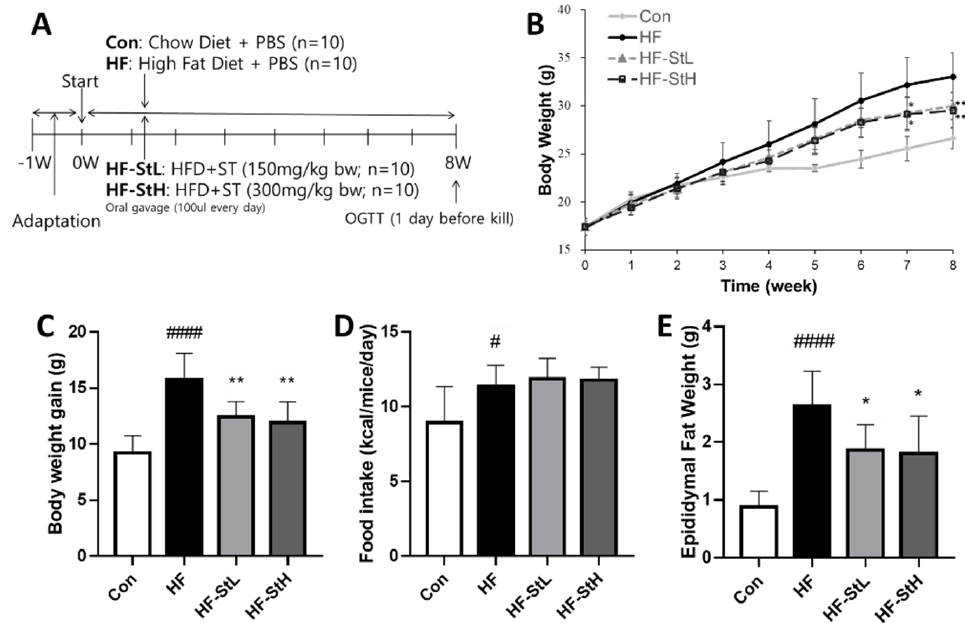
Figure 4. Effects of S. thunbergii (ST) extract on body weight and organ weight in high-fat-fed C57BL/6 mice. ( A ) Experimental timeline. ( B ) Trend of body weight change for 10 weeks. ( C ) Body weight gain. ( D ) Average food intake for 10 weeks. ( E ) Epididymal fat weight. Con: chow diet, HF: high-fat diet, HF-StL: high-fat diet+ST extract 150 mg/kg bw, HF-StH: high-fat diet+ST extract 300 mg/kg bw. All data are presented as means ± SD (n = 10). Compared between the control and the high-fat diet group; # p < 0.05, #### p < 0.0001 by student t-test. Compared with the high-fat diet group, * p < 0.05, ** p < 0.01 by one way ANOVA followed by Dunnett’s